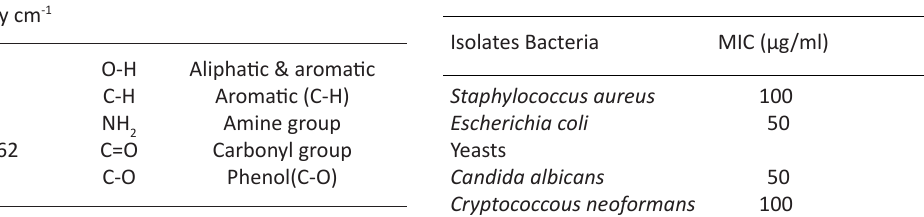
Table 5. Full scan of the IR spectrum of alkaloid extract Band Bond Function group